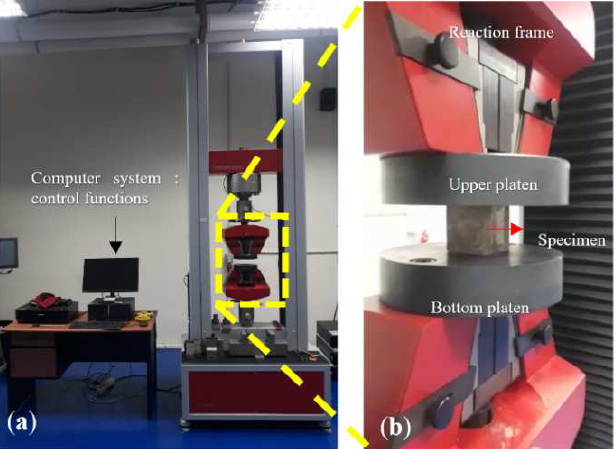
Figure 3. Compressive strength test, ( a ) testing machine, and ( b ) test setup of the specimens.